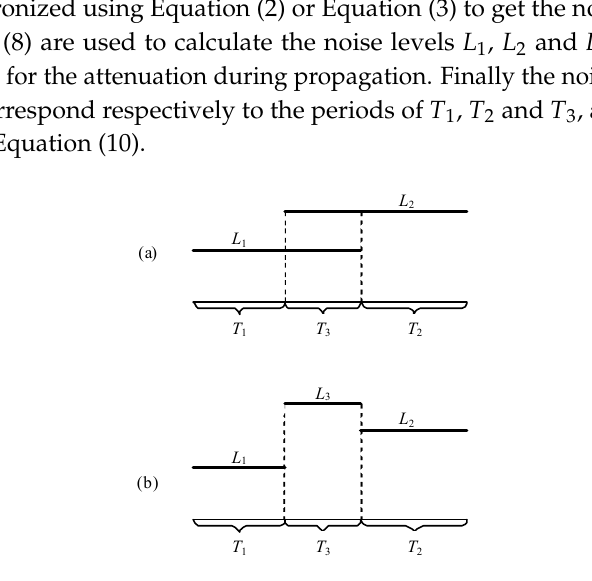
Figure 1. Illustration of overlap of multiple noises. ( a ) Before summing for T 3 ; ( b ) After summing for T 3